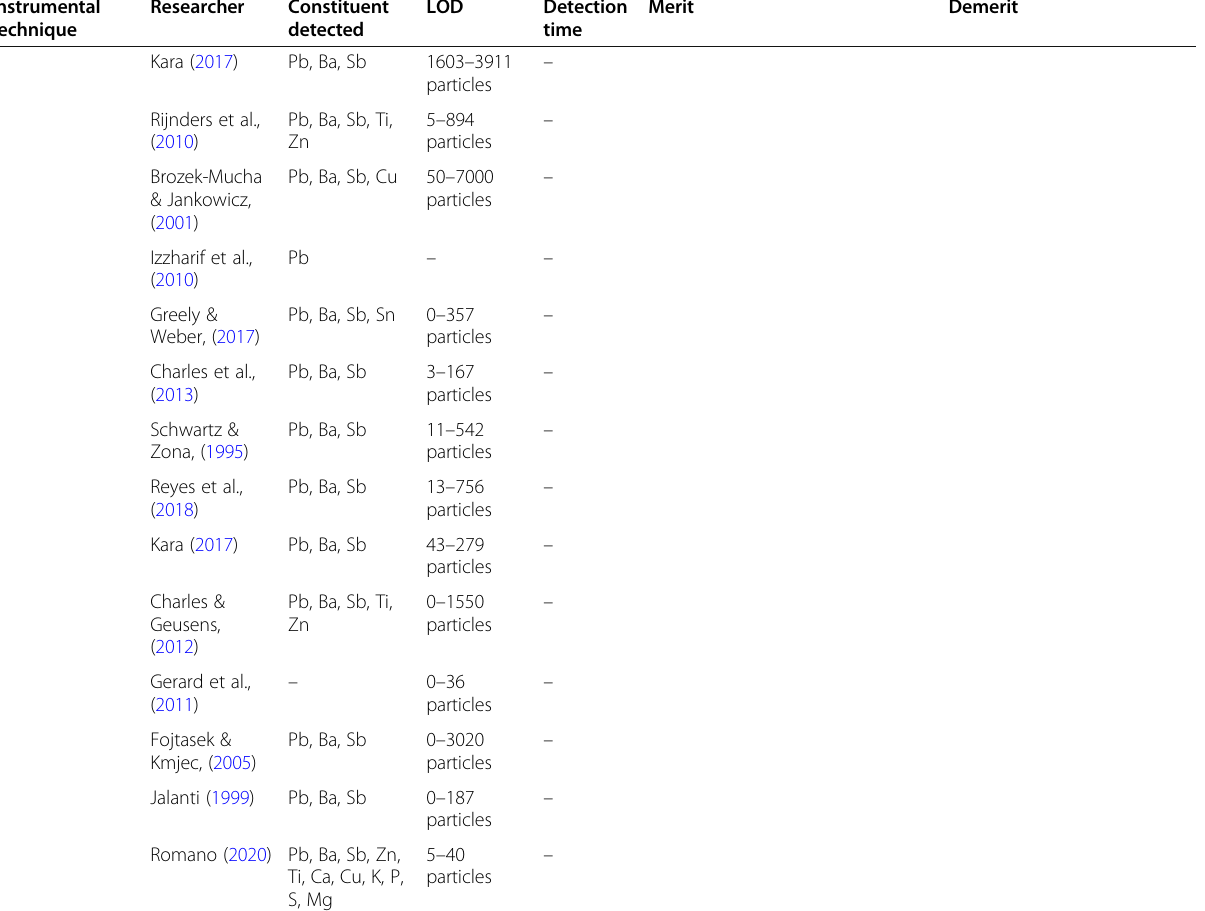
Table 4 Combined analysis of organic and inorganic gunshot residues using instrumentation technique (Continued) Instrumental